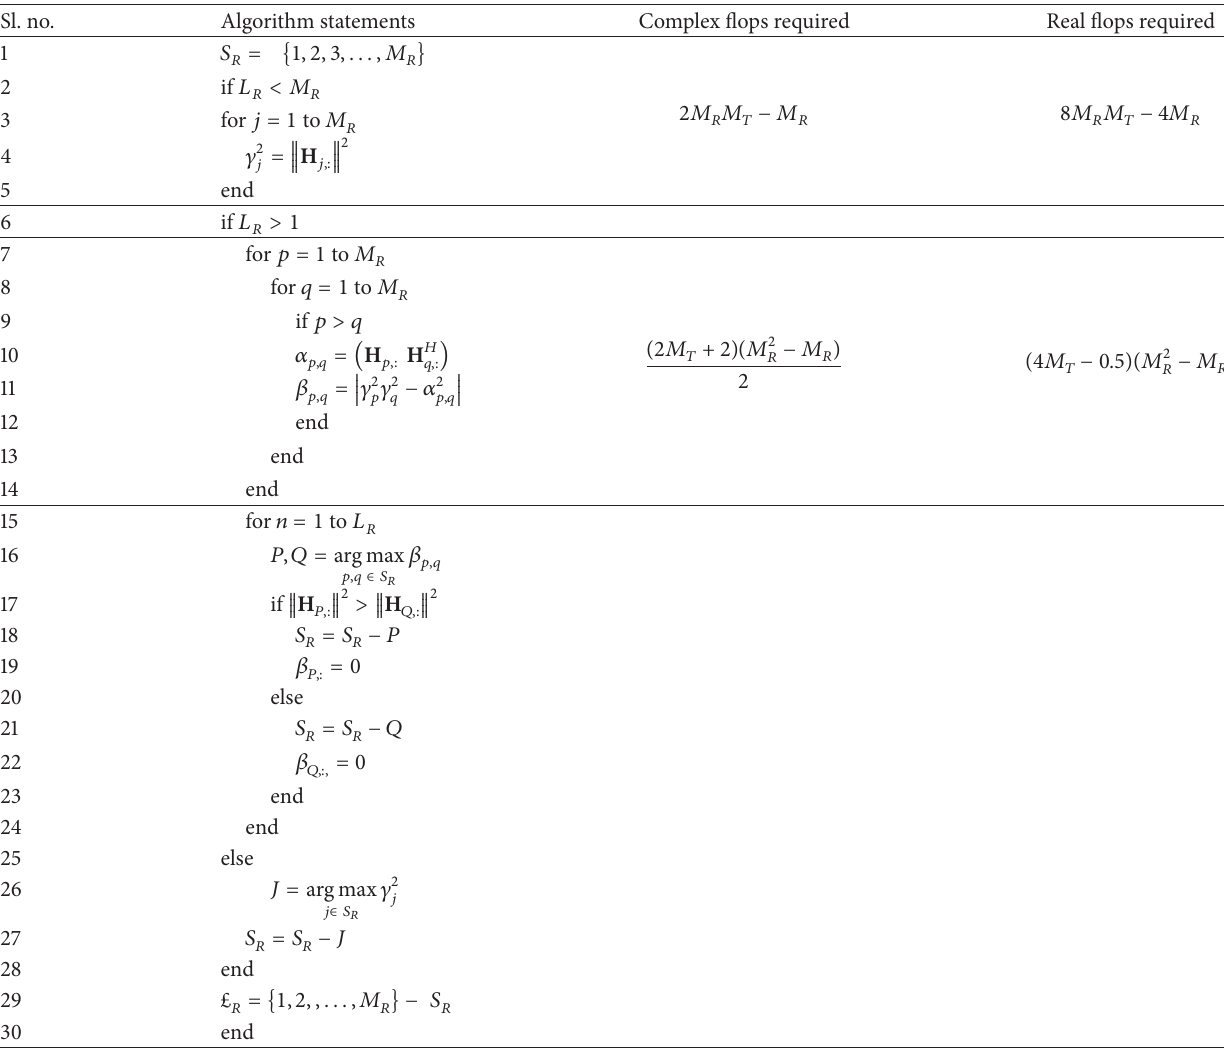
Table 1: Pseudostatements and complexity details of the proposed algorithm. Sl.